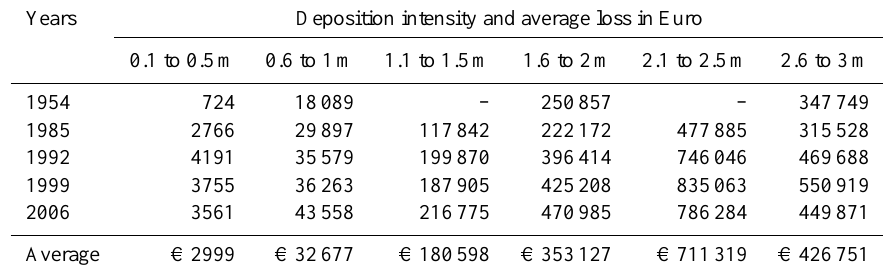
Table 4. Resulting loss values in Euro in comparison with the deposit intensity in